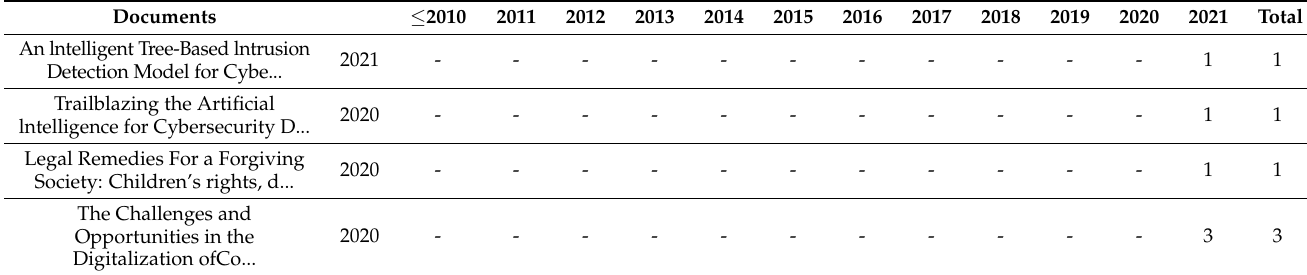
Table A1. Overview of document citations period ≤ 2010 to